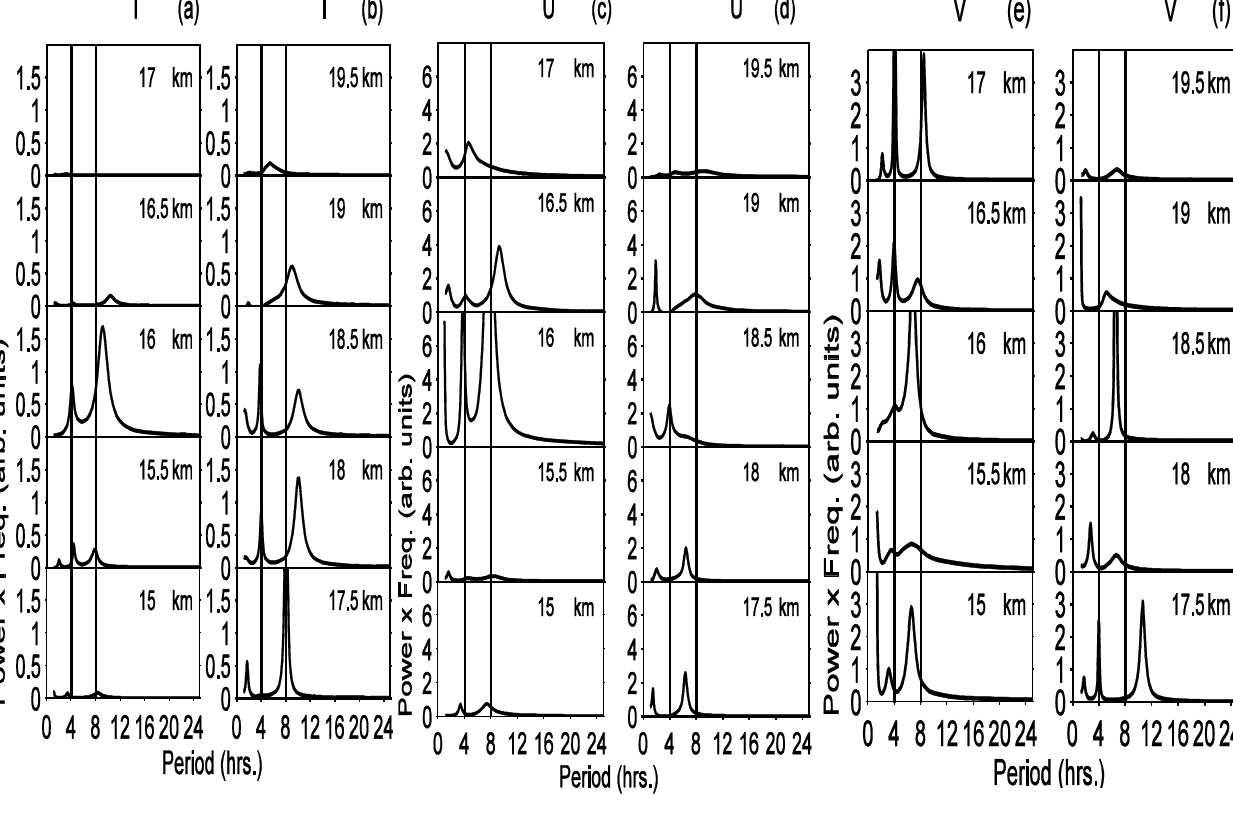
Fig. 9. Same as Fig. 8, but for 9 December Figure 9. Same as Figure 8, but for 09 December 2005.